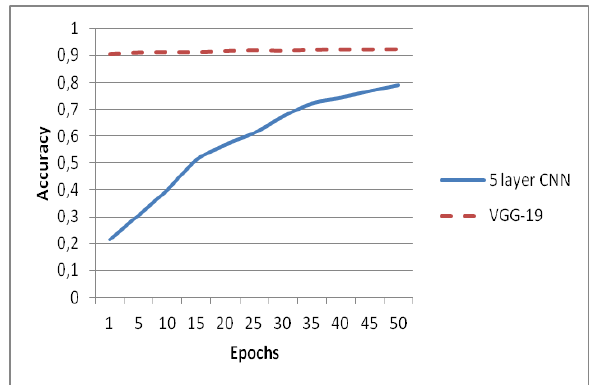
Figure 7 . Characteristics of the validation set processing for the left eye